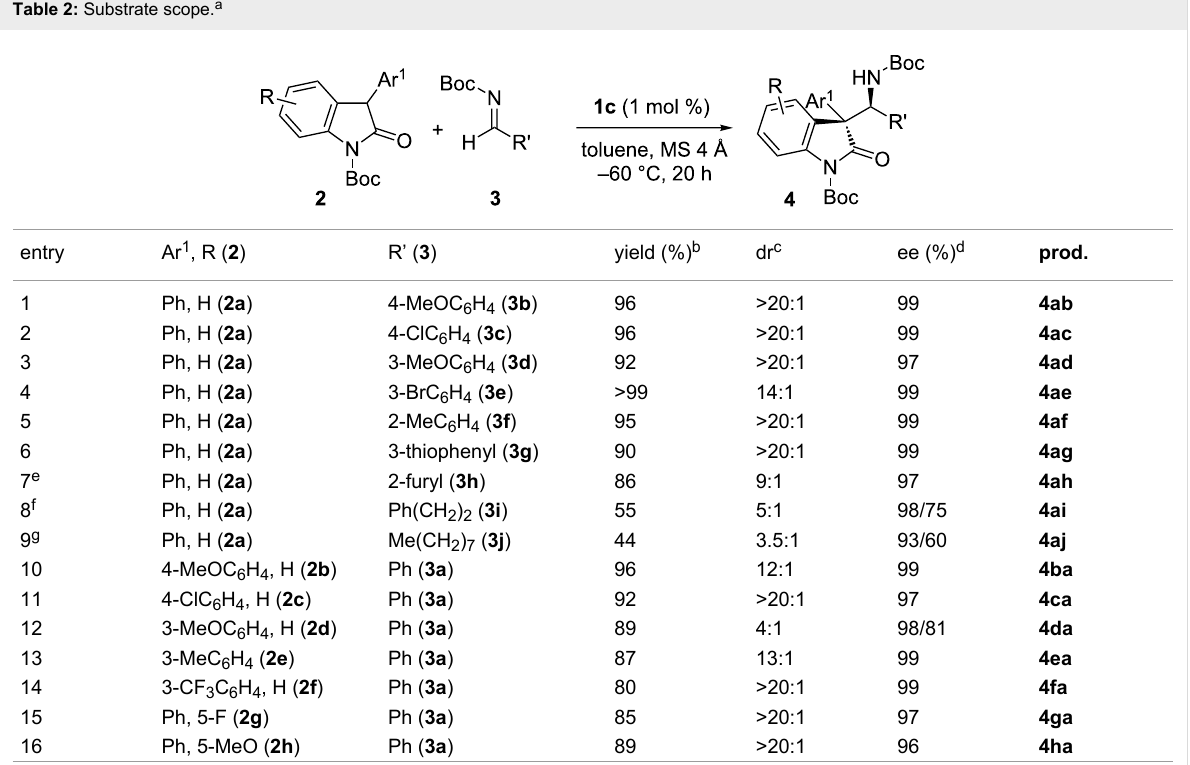
Table 2: Substrate scope.